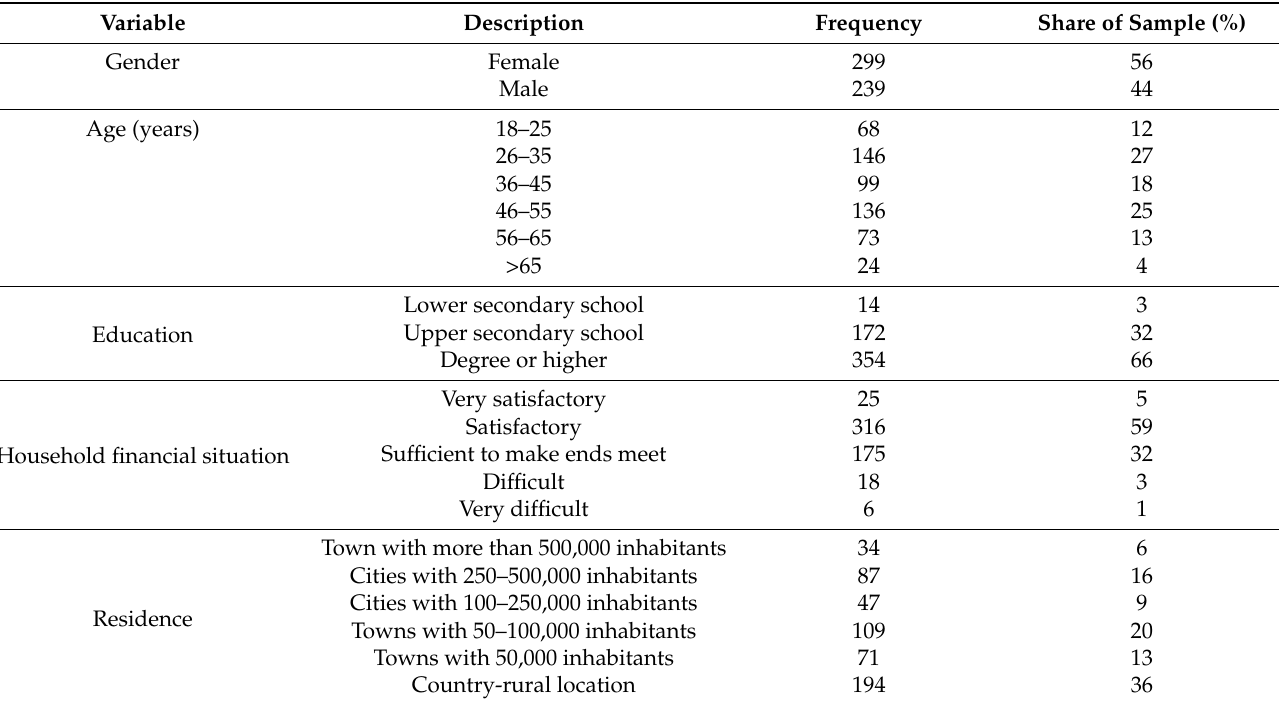
Table 1. Socio-demographic characteristics of the